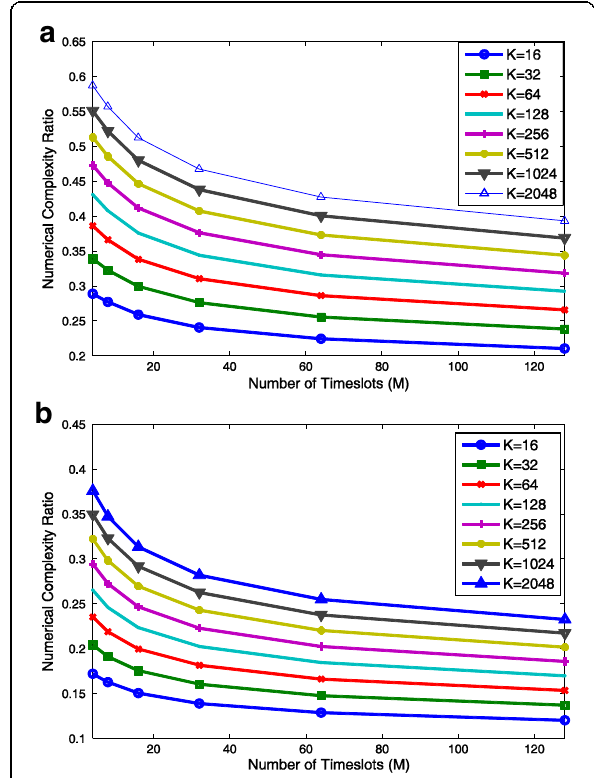
Fig. 11 The complexity of GOFDM MMSE receiver relative to GFDM DSIC/MF receiver with I = 2 and a J = 4 and b J = 8